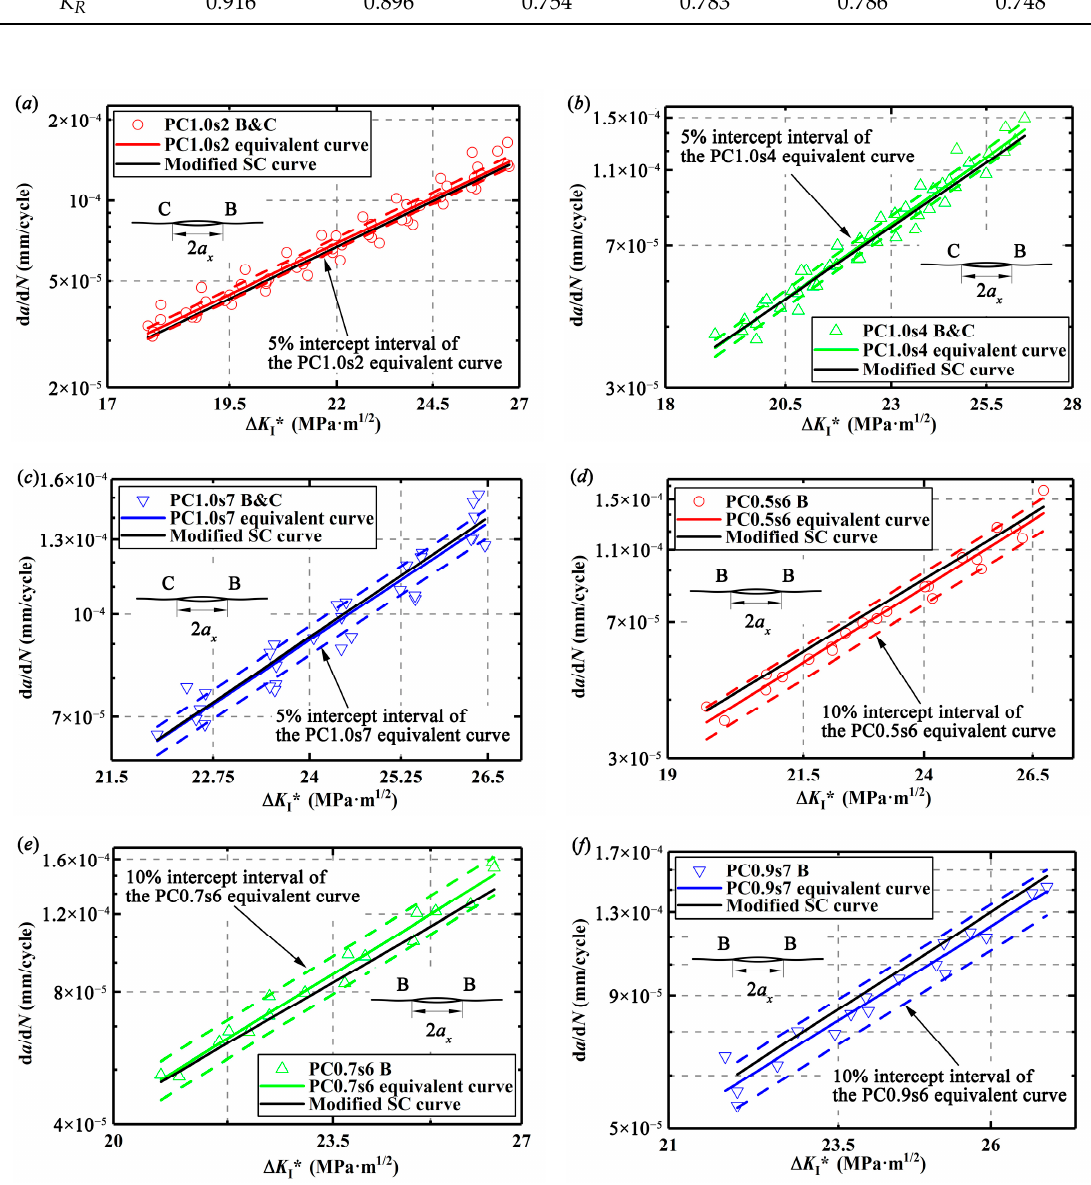
Figure 14. Comparison of simplification method and the ASME method for the double parallel cracks: